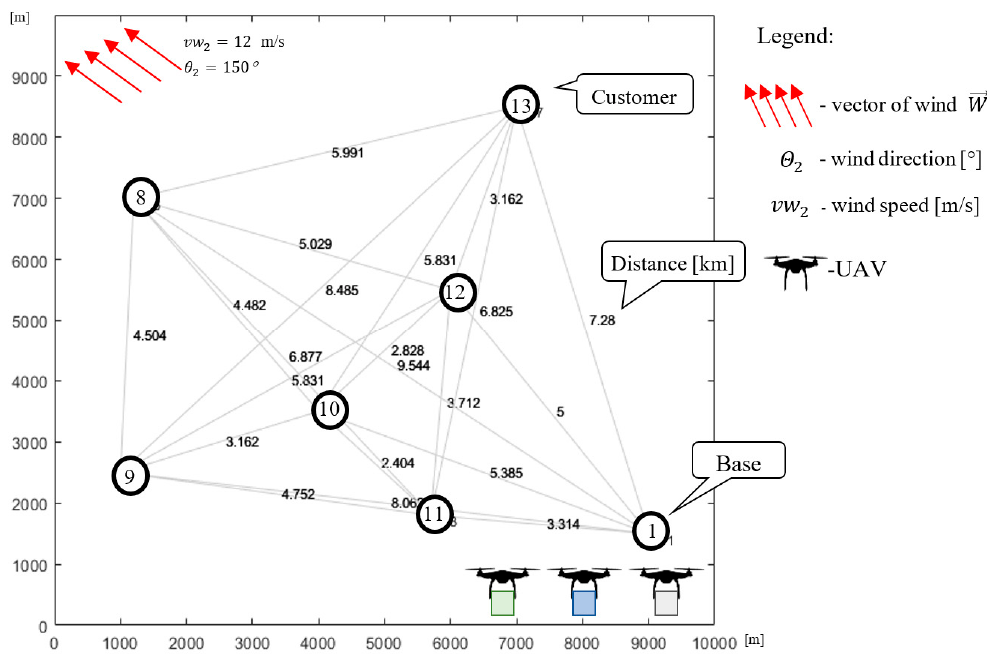
Figure 9. Transportation network from Cluster #2.